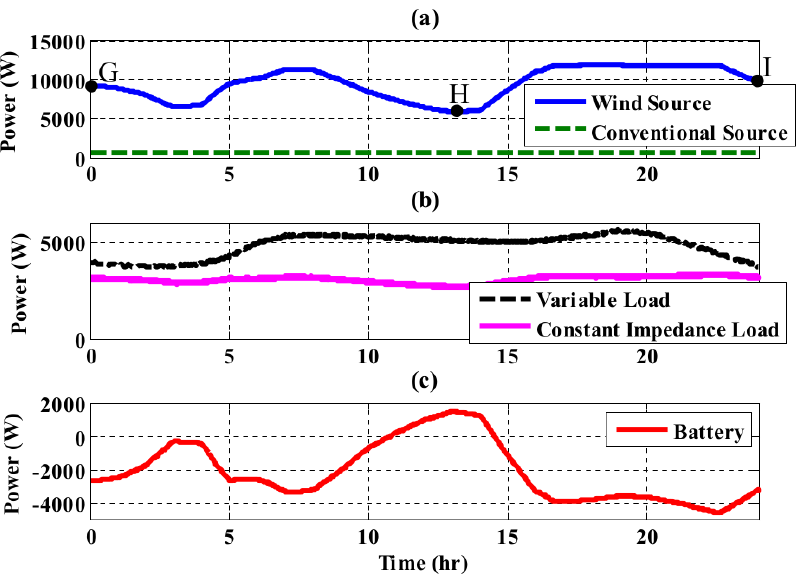
Figure 21. Simulation results using optimal multidimensional droop control: ( a ) power supplied by each source; ( b ) power consumed by each load; and ( c ) power supplied by the